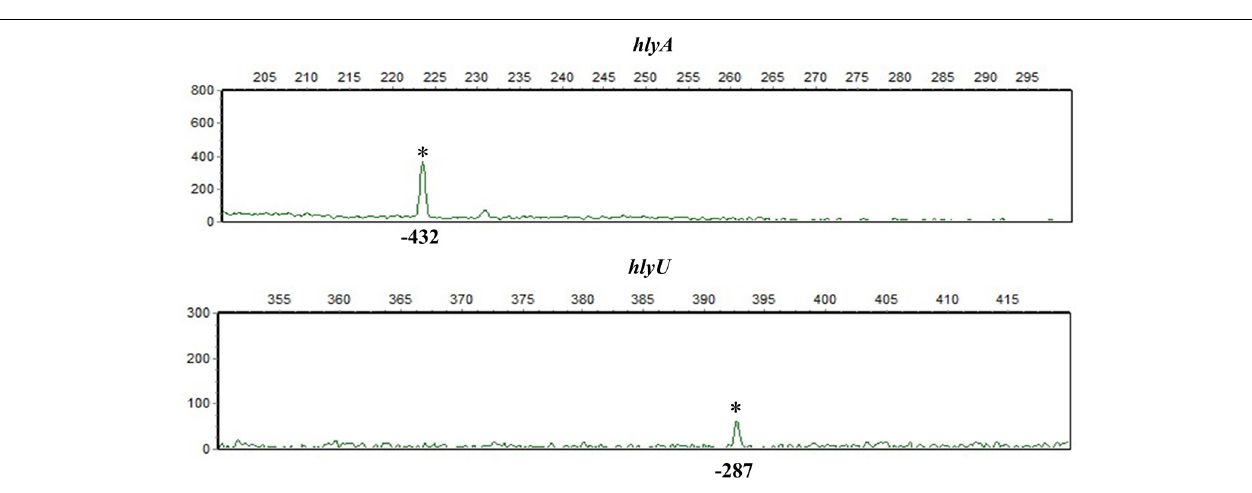
FIGURE 6 | Transcription start sites of hlyA and hlyU . A 5’-HEX-labeled oligonucleotide primer was designed to be complementary to the RNA transcript of each target gene. The primer extension products were analyzed with an ABI 3500XL DNA Genetic analyzer. The transcription start sites are marked with asterisks and